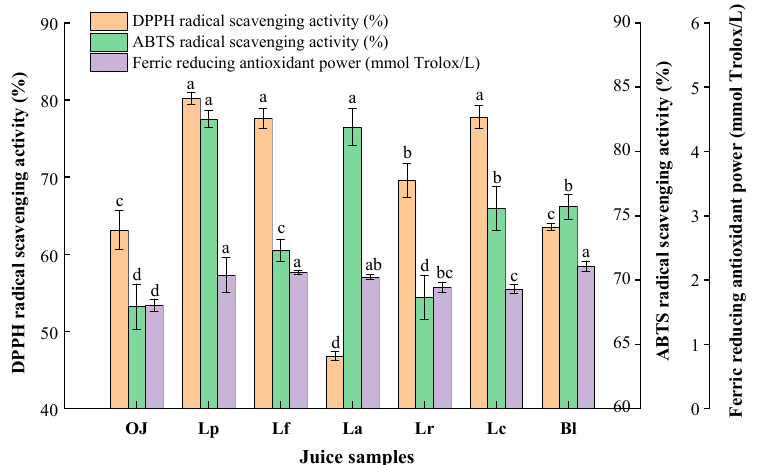
Figure 5. Antioxidant activities of the orange juices fermented by Lactiplantibacillus plantarum (Lp), L . fermentum (Lf), L . acidophilus (La), L . rhamnosus (Lr), L . paracasei (Lc), Bifidobacterium longum (Bl) and control ( n = 3). Control (OJ) was original orange juice. a–d Different letters in the same column indicate significant differences ( p < 0.05).